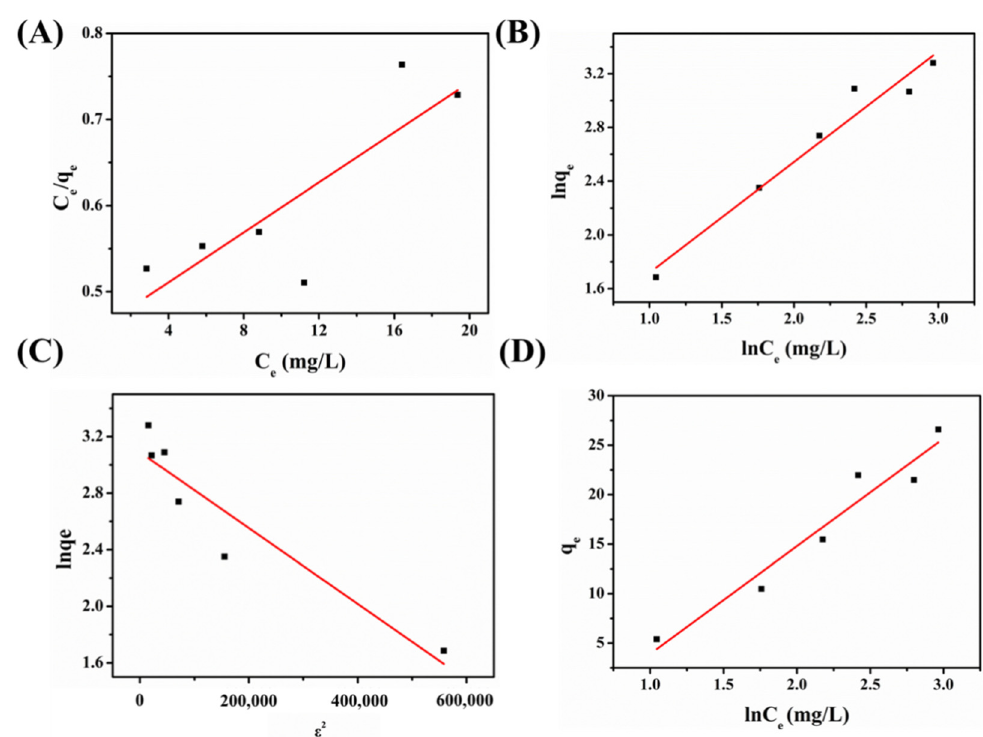
Figure 7. ( A – D ) Isotherm plots of 1 for the BF adsorption by the Langmuir, Freundlich, Dubinin– Radushkevich, and Temkin models. Table 3. The isotherm parameters for the adsorption of BF dyes